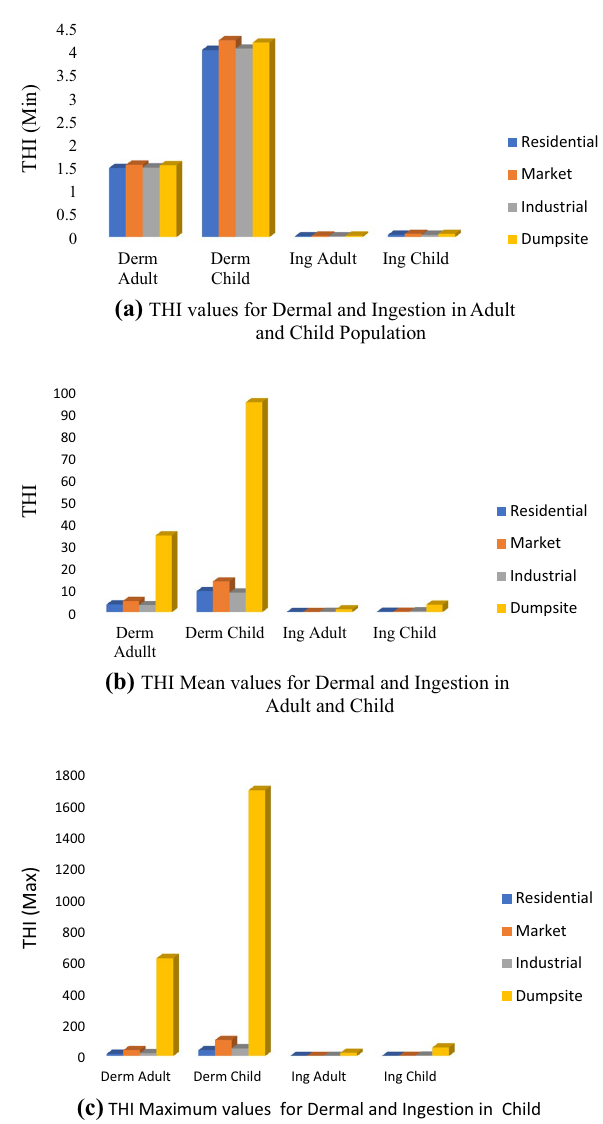
Fig. 7 a .THI values for Dermal and Ingestion in Adult and Child Population. b THI Mean values for Dermal and Ingestion in Adult and Child. c THI Maximum values for Dermal and Ingestion in Child and